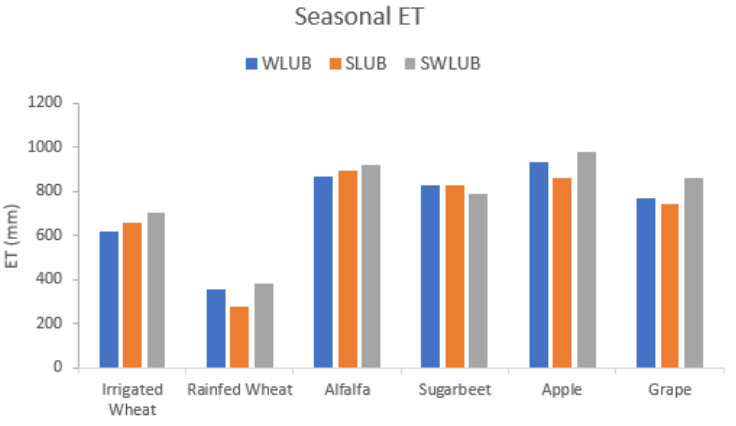
Figure 7. Seasonal evapotranspiration (ET) in agricultural sections in LUB.